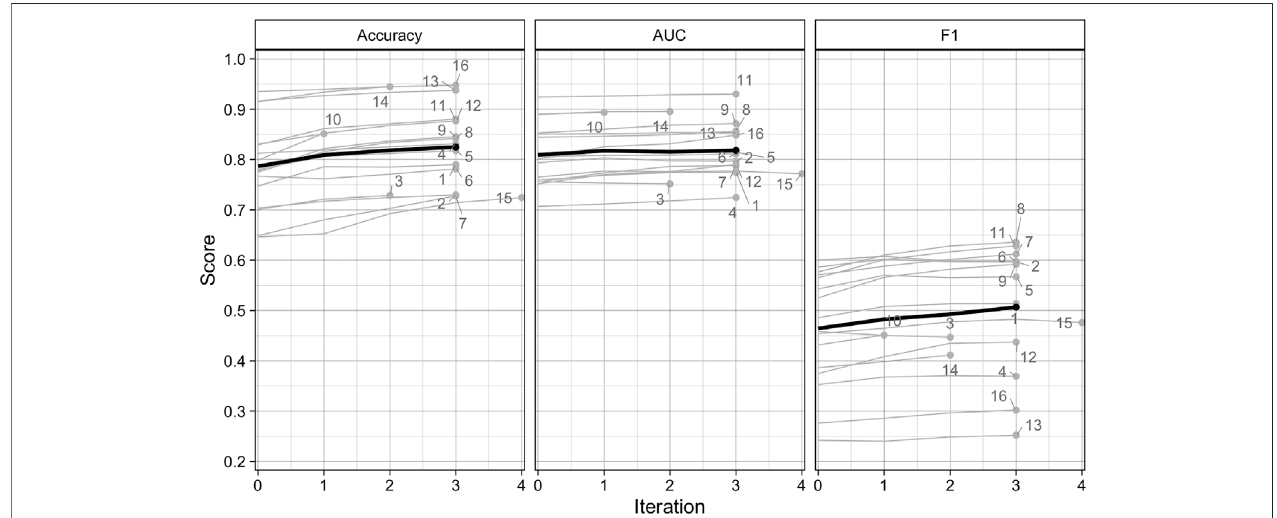
FIGURE 4 | Scores for overall accuracy, area under the curve of the Receiver Operating Characteristic, and the F1 scores for the Random Forests model results after each iteration of the active learning loop for each AOI (gray lines), as well as the mean score per iteration across all AOIs (black